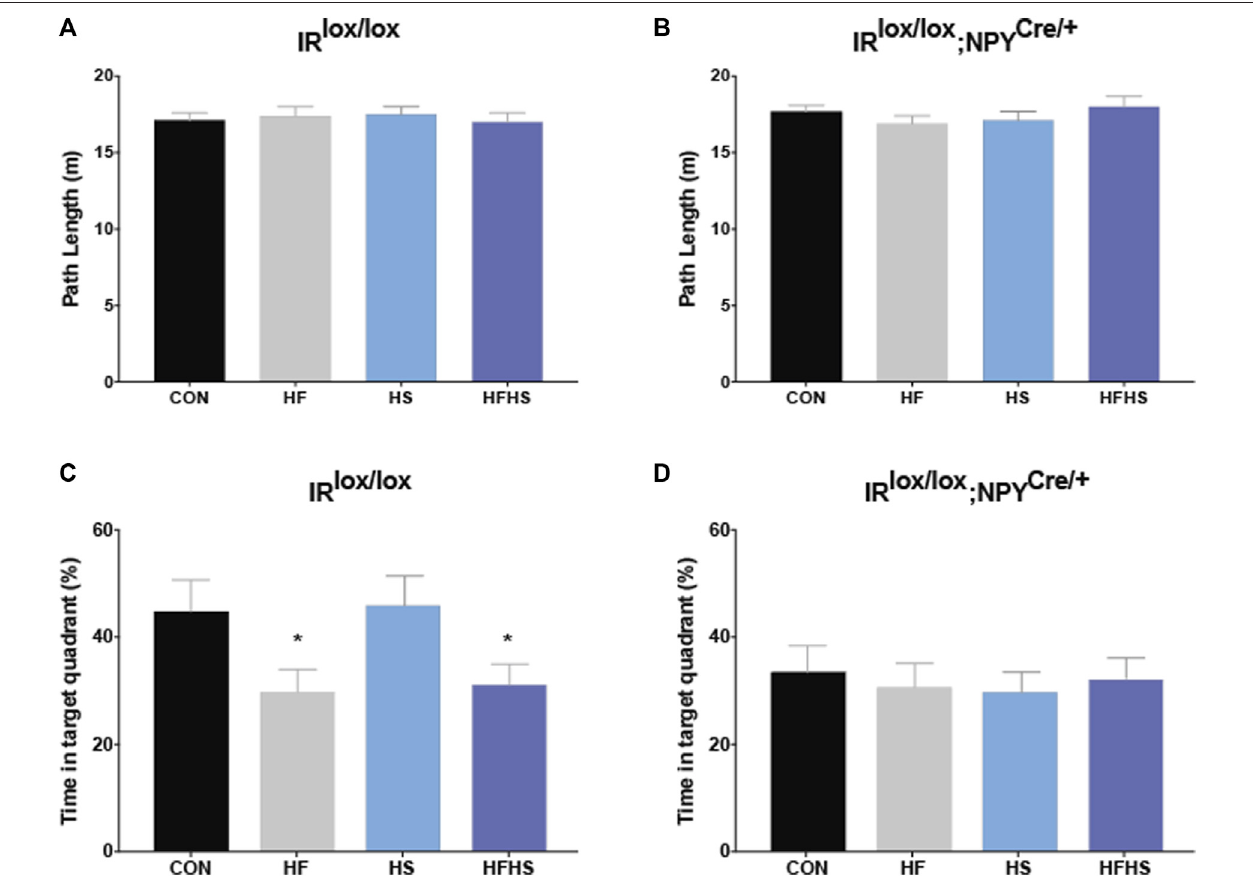
FIGURE 4 | Morris Water Maze Performance - Probe trial. Time spent in the target quadrant was measured to assess hippocampal-dependent memory. IR lox/lox control mice and IR lox/lox ;NPY Cre/+ mice across all dietary groups swam similar path lengths in the target quadrant during the probe trial (A, B) . IR lox/lox mice fed a HF or HFHS diet spent less time in the target quadrant relative to IR lox/lox mice fed a CON or HS diet (C) . There was a main effect of genotype on time spent in the target quadrant, with IR lox/lox ;NPY Cre/+ mice in all dietary treatment groups spending less time in the target quadrant than IR lox/lox CON mice (D) . CON = chow diet, HF = highfatdiet,HS=highsugardiet,HFHS=highfatandhighsugardiet.Valuesareexpressedasmean±SEM.*=p < 0.05.AnalysedbyafactorialANOVA.IR lox/lox ; n =48 (12/diet group). IR lox/lox ;NPY Cre/+ ; n = 48 (12/diet